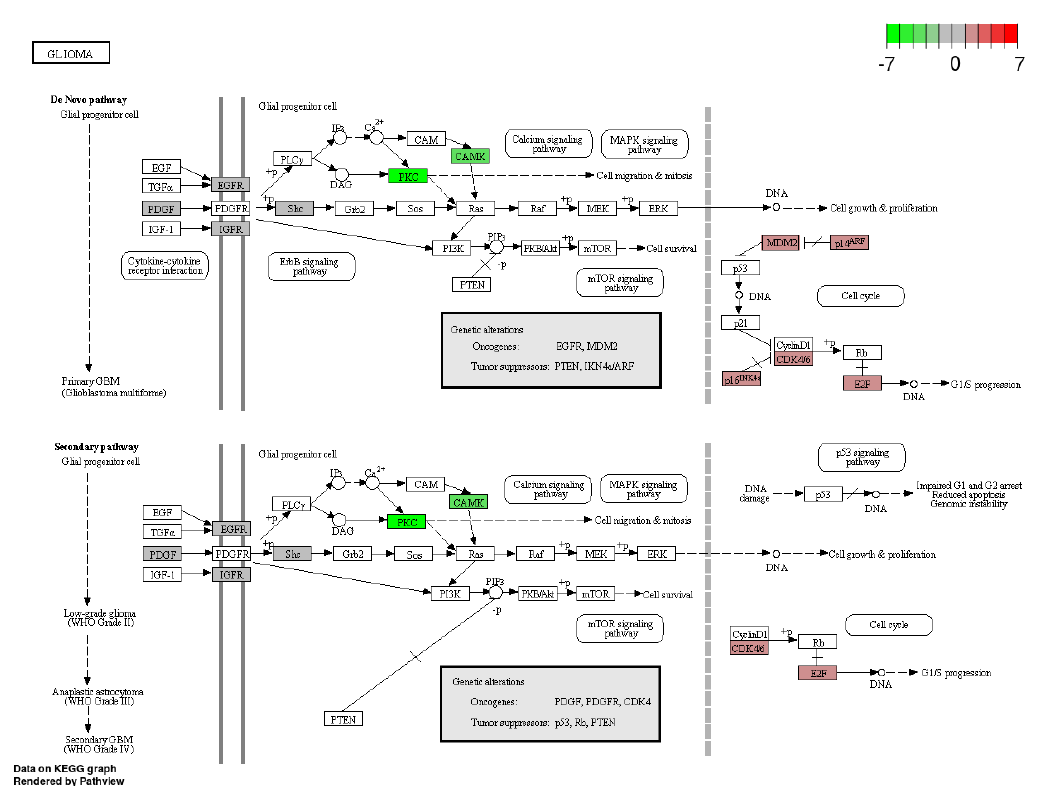
Figure 6. Pathways enrichment analysis : glioma pathway. Red defines genes that are up-regulated and green defines genes that are down-regulated.